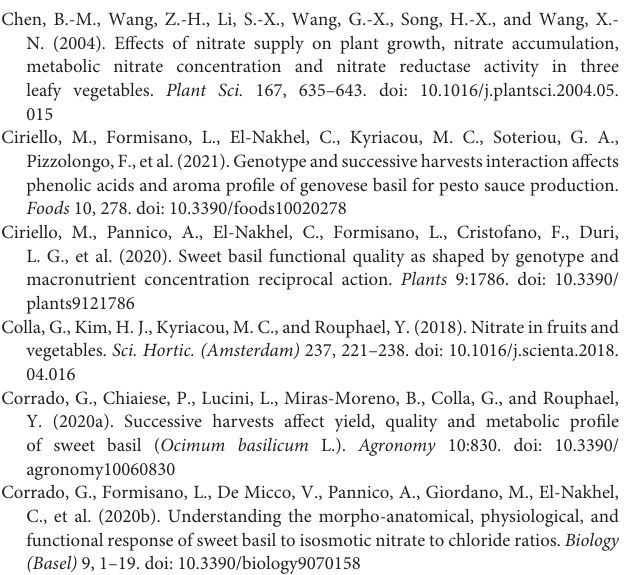
Supplementary Figure 1 | Chromatograms of phenolic acids in Genovese basil extract by HPLC at density D2 with separation of caffeic acid (1), ferulic acid (2), chicoric acid (3), and rosmarinic acid (4). (A,B) Aroma 2 at first and second cut. (C,D) Eleonora at first and second cut. (E,F) Italiano Classico at first and second cut. Supplementary Figure 2 | Scree plot of the eigenvalues of the principal